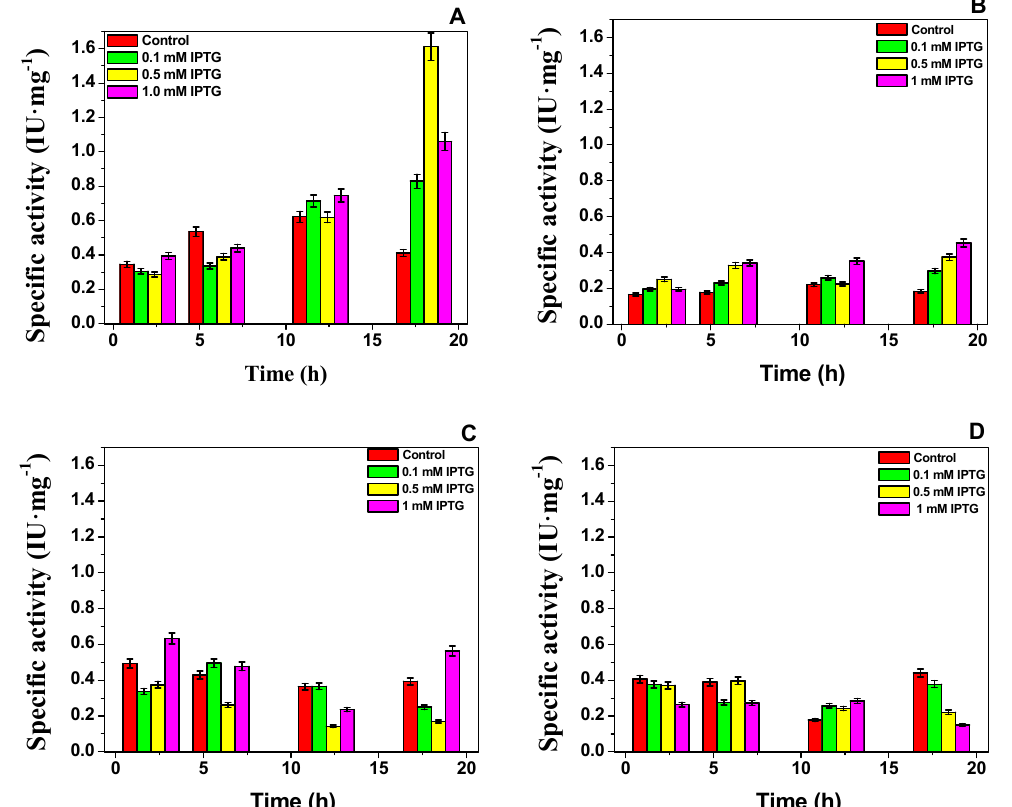
Figure 3. Expression assays of G6PDs in Escherichia coli BL21(DE3) ∆ zwf :: kanr r . ( A ) Expression of human WT G6PD, two single mutants Class II; ( B ) G6PD A+; ( C ) G6PD Nefza; and ( D ) one double mutant Class II G6PD A − . Specific activity was measured in the crude extract and was used as indicative of the expression levels of soluble recombinant protein. Statistical data were obtained from the three assays. Table 1. Purification summary of three recombinant human G6PD enzymes. G6PD Total Protein (mg)